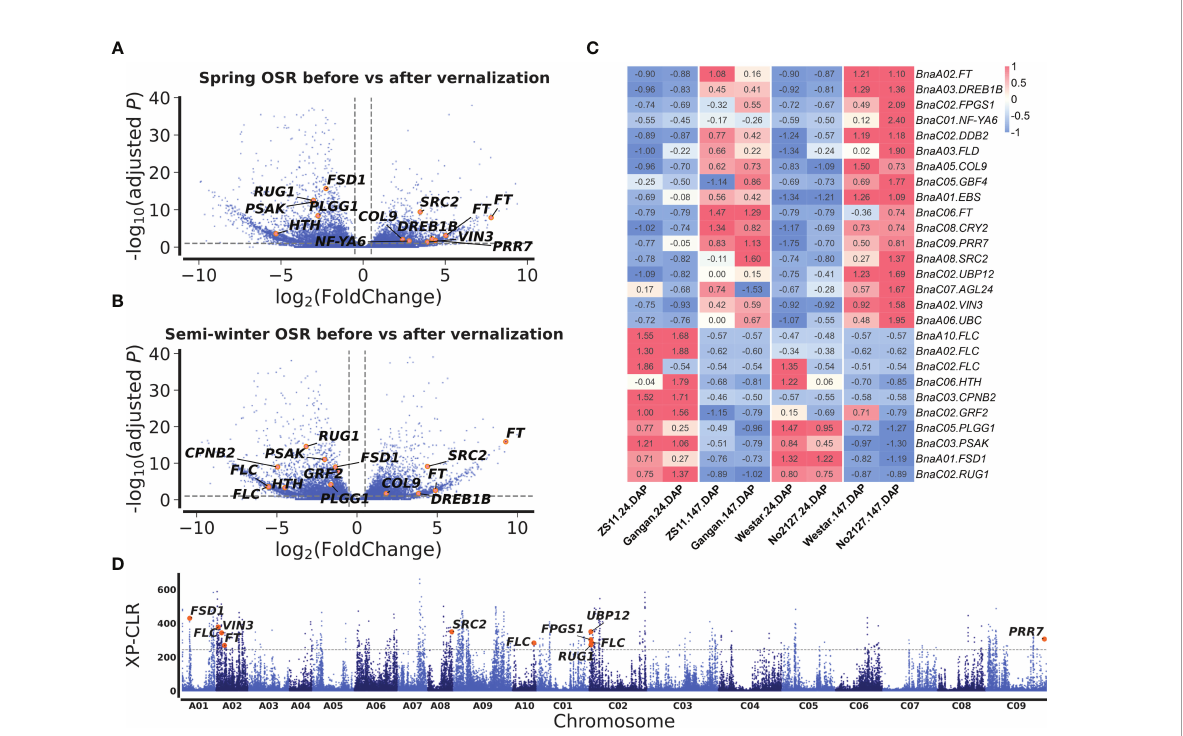
FIGURE 3 Differentially expressed gene (DEG) analysis before and after vernalization and selection sweeps between semi-winter and spring oilseed rapes (SWORs and SORs). Volcano plots of DEGs in SORs (A) and SWORs (B) . The y-axis is the adjusted p -value and the x-axis is log 2 fold-change (FC) before and after vernalization. Gray lines are at the absolute value of log 2 FC = 1 or adjusted p -value = 0.05. (C) The expression pro fi ling of 27 candidate genes around main-effect QTNs and QEIs for fl owering time in two SWORs and two SORs in the 2018 – 2019 growing season in Wuhan. DAP, days after planting. (D) Selective sweeps between SWORs and SORs by XP-CLR. The horizontal dashed lines indicate the cutoff in the top 1% of XP-CLR scores. Candidate genes for fl owering time are marked above the selective sweep